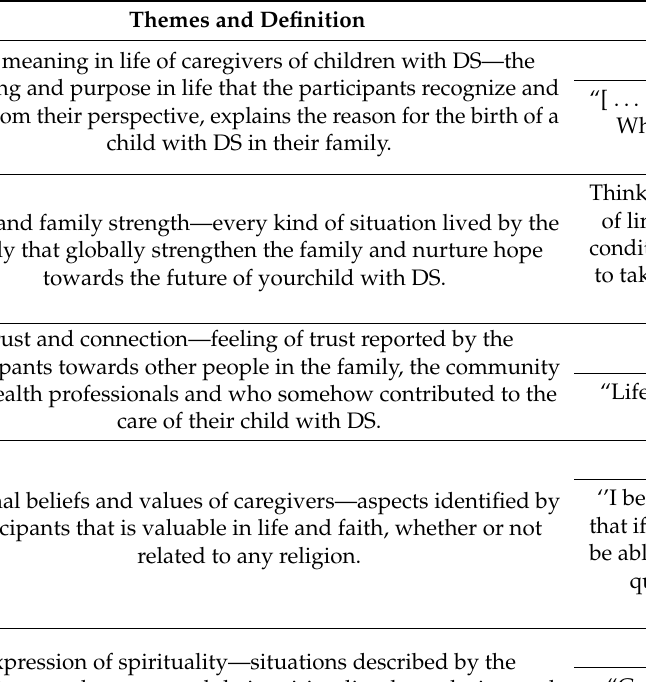
Table 1. Themes, definition, and illustrative